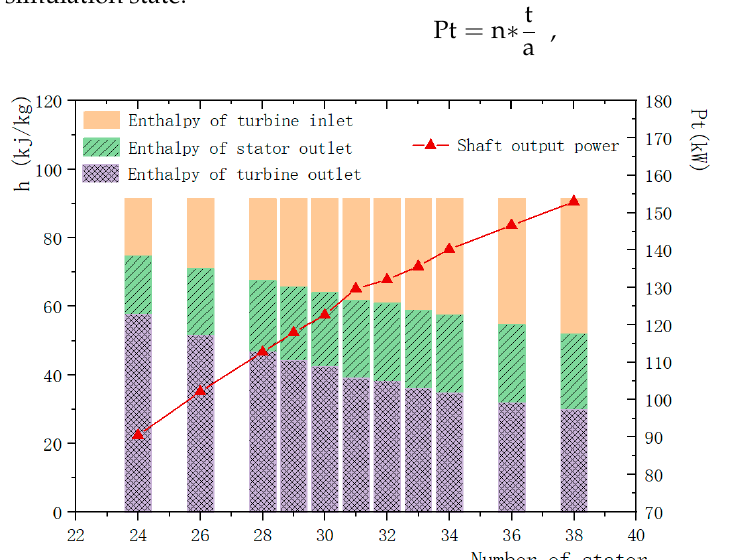
Figure 12. The influence of the number of stator blades on the enthalpy of the turbine inlet and outlet, the enthalpy of the stator outlet and the shaft power.